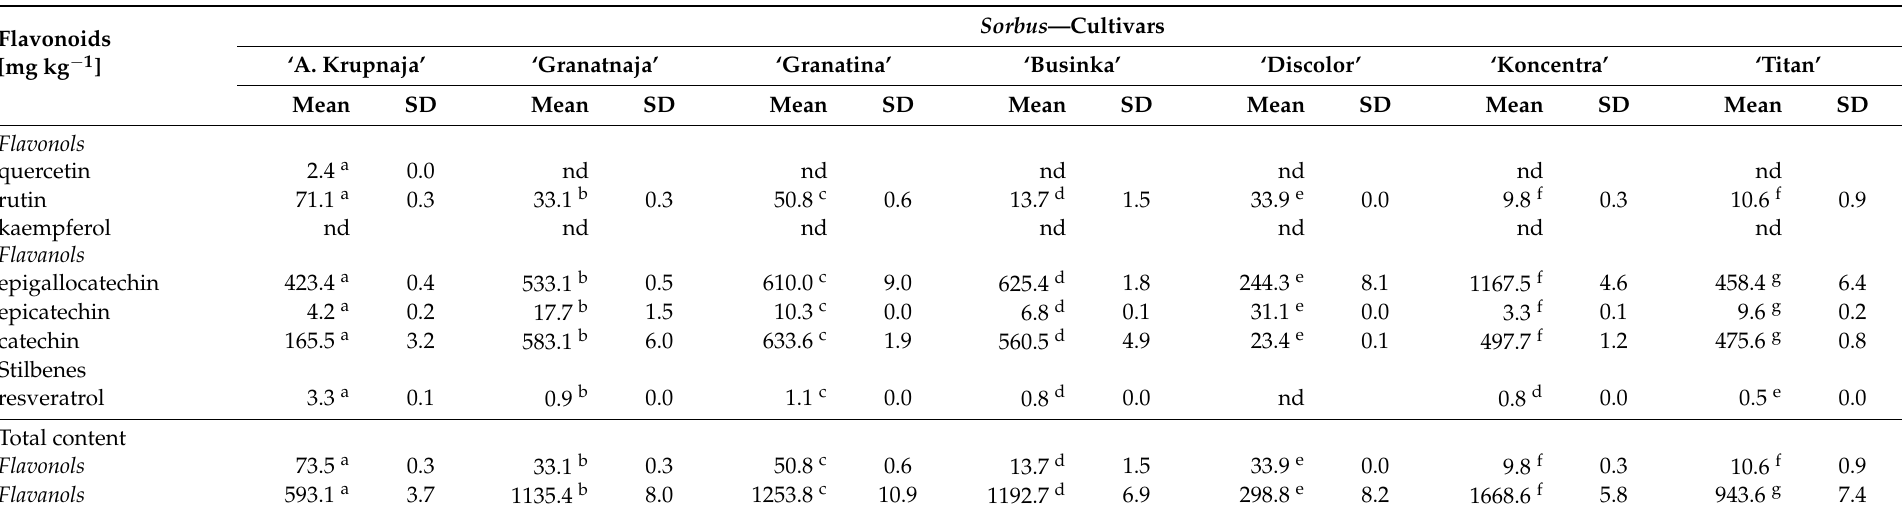
Table 4. Total flavonoid content and contents of individual flavonoids and stilbenes [mg kg − 1 ] in the selected Sorbus